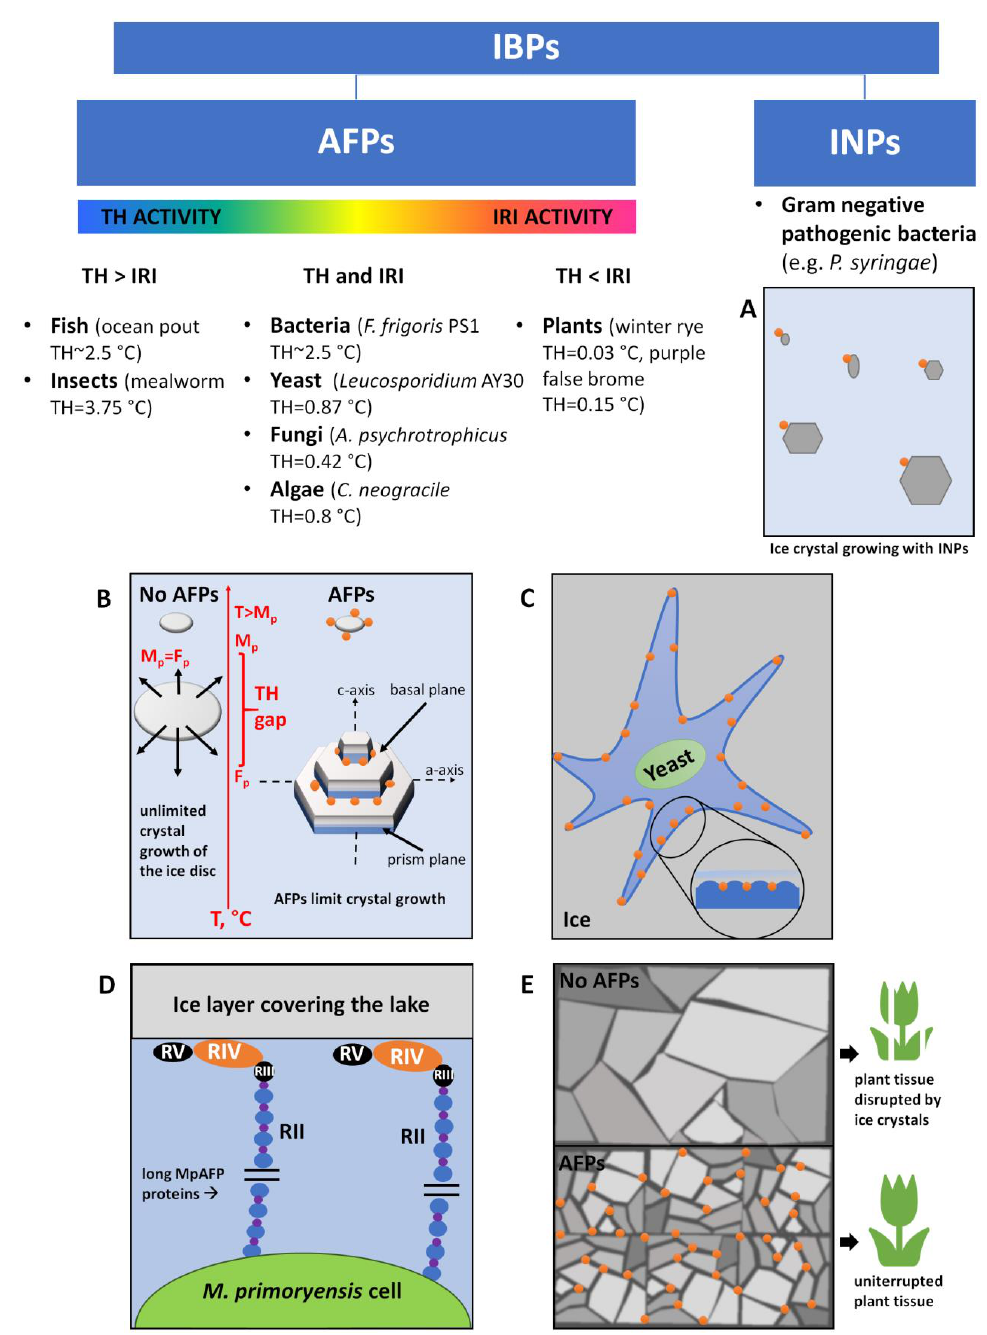
Figure 1. Classification, activities, and sources of the ice binding proteins (IBPs). IBPs can be divided into: ( A ) ice-nucleating proteins (INPs) that initiate the formation of ice crystals at high subzero temperatures, and ( B – E ) antifreeze proteins (AFPs) that decrease the freezing point of body fluids in organisms to avoid freezing. AFPs display the activities of: ( B ) thermal hysteresis (TH; M p stands for melting point, F p —for freezing point), and ( E ) ice recrystallization inhibition (IRI); with some organisms displaying high TH, but low / no IRI activity (fish, insects), other—moderate TH and IRI activities (microorganisms), and plants exhibiting high IRI / low TH activity. Moreover, microorganisms produce secreted AFPs ( C ) that allow them to survive inside the ice crystal, and AFPs ( D ) that may keep the bacterium in water under the ice, assisting in providing an access to O 2 and nutrients. IBPs are visualized by orange dots in panels ( A – E ), water is colored blue, and ice gray.